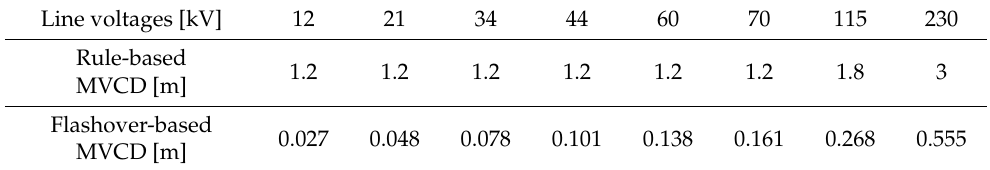
Table 4. Rule-based MVCD and flashover-based MVCD depending on varying line voltages. Line voltages